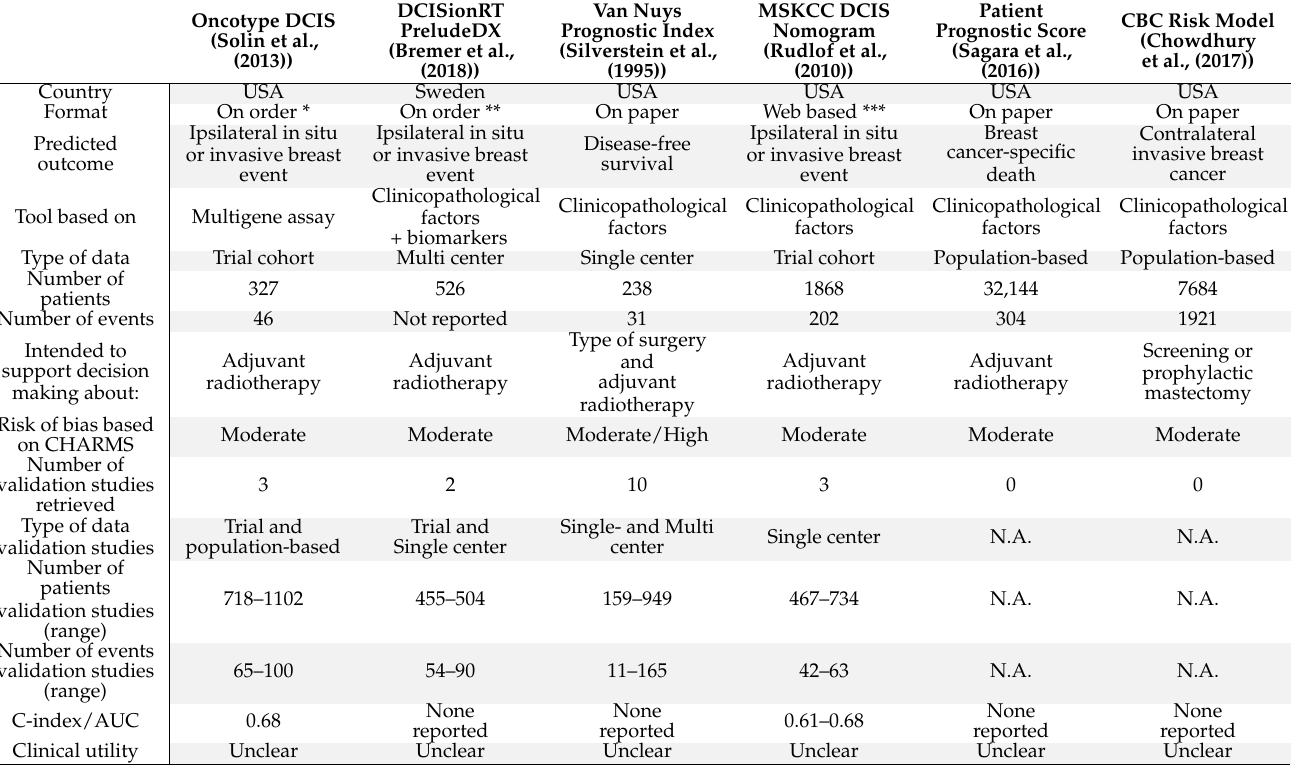
Table 2. Overview of prediction models predicting subsequent breast events after